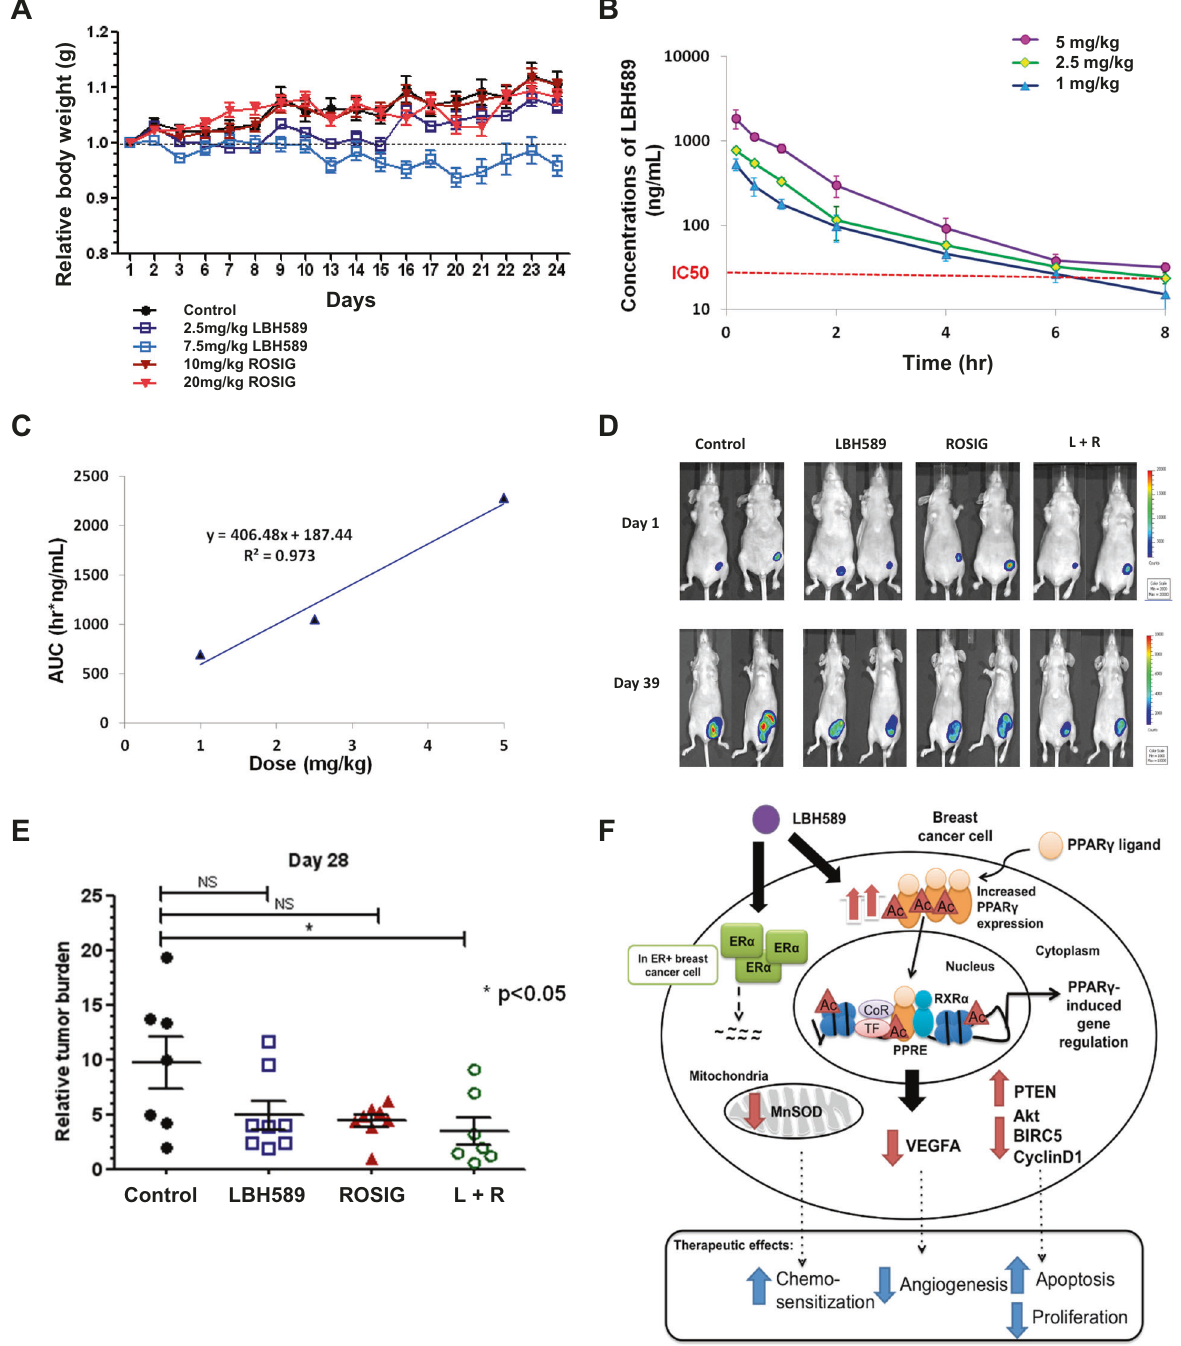
Fig. 6 Pharmacokinetic optimization and in vivo antitumor effects of rosiglitazone and LBH589. A The body weight changes of mice for the toxicity study from day 1 until day 24. Mice were weighed fi ve times a week prior to treatment. Mice were treated with LBH589 at 2.5 mg/ kg or 7.5 mg/kg, Rosiglitazone at 10 mg/kg or 20 mg/kg. Control mice received 10% DMSO as a vehicle ( n ≥ 7 animals per group). B Mice were dosed with 1 mg/kg, 2.5 mg/kg, and 5 mg/kg of LBH589, and serum concentrations of the drug were assessed at 10 min, 30 min, 1 h, 2 h, 4 h, 6 h, and 8 h post-treatment. Values represent mean ± SD ( n = 3). C The association between doses of LBH589 and the values of AUC after intravenous injection of LBH589 at doses of 1 mg/kg, 2.5 mg/kg, and 5 mg/kg. D In vivo bioluminescence of tumors from the luciferase- expressing MDA-MB-231 cells in the abdominal mammary fat pad of mice at day 1 and 28, respectively. Luciferin substrate was injected into the intraperitoneal cavity of the mice and bioluminescence was examined after 10 min to obtain photon counts. Data for representative mice (two from each group) are shown. E Therapeutic ef fi cacy of the LBH589 and Rosiglitazone or combination of both against mammary fat pad tumor growth in an orthotopic murine model at day 28. Mice were treated with 2.5 mg/kg LBH589, 10 mg/kg Rosiglitazone, or a combination of both from day 1 to day 28 when the tumors reached 10 7 signals. Control mice received 10% DMSO as a vehicle solution. Relative tumor burden was calculated against the tumor bioluminescent signal just before treatment started ( n ≥ 7 animals per group; mean ± SEM; * p ≤ 0.05 compared with negative control unless otherwise stated). F Model of combinational therapy of LBH589 and PPAR γ ligands in breast cancer